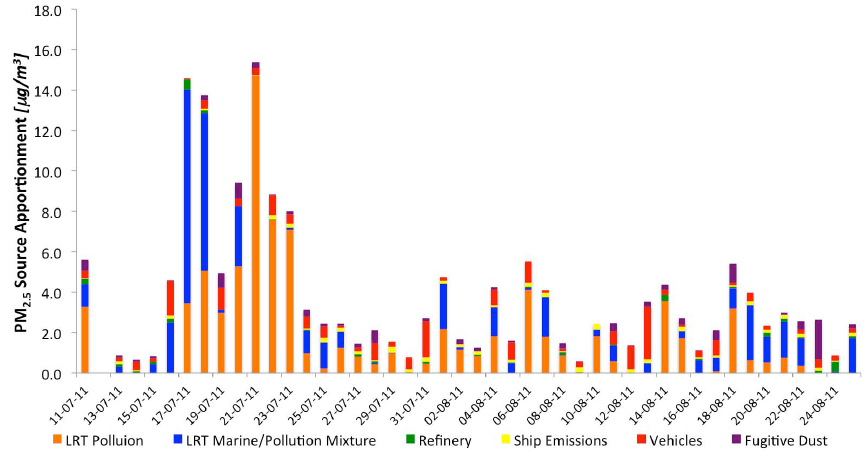
Fig. 9. Time series of PM 2 . 5 source apportionment based upon PMF output